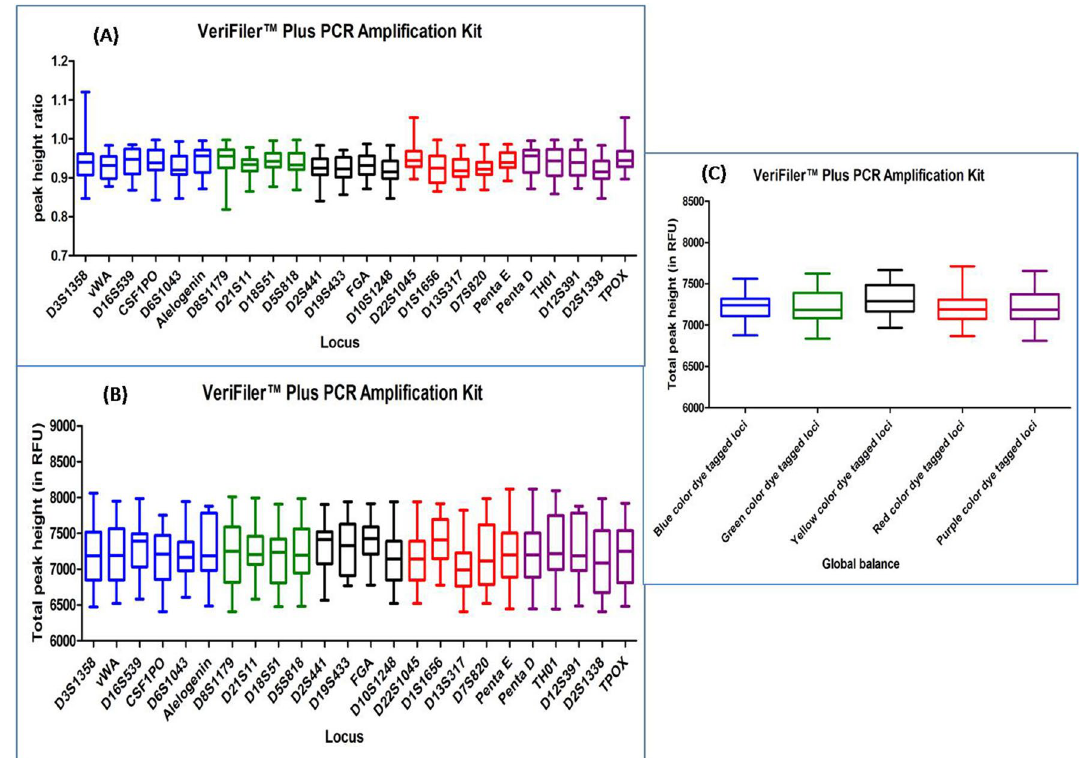
Figure 9. Quality assessment of DNA profile by Dunn’s multiple comparison test for the VERIFILER PLUS PCR AMPLIFICATION KIT ( A ) Peak height ratio ( B ) Total peak height ( C ) Global